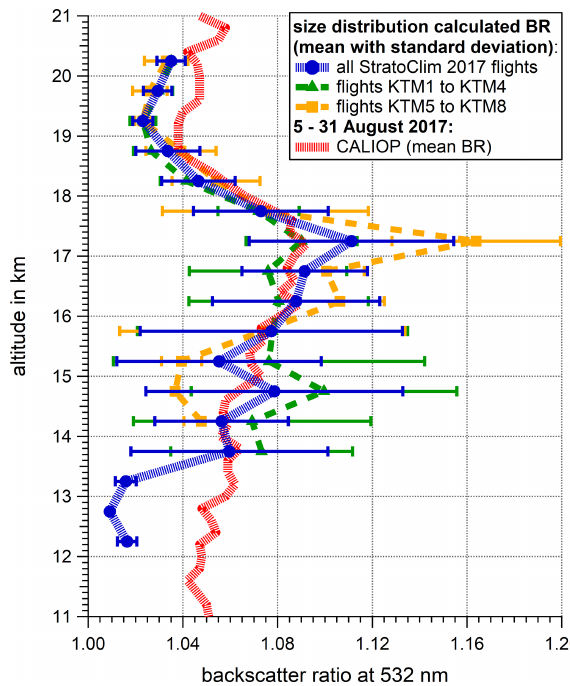
Figure 8. Vertical mean profile of the backscatter ratio at a 532nm wavelength, calculated based on the aerosol size distributions mea- sured during the 2017 StratoClim measurement campaign with the standard deviation shown as horizontal bars. The full period of the 2017 StratoClim field campaign is shown in blue, the first half of the campaign period is shown in green (flights KTM1 to KTM4), and the second half of the campaign period is shown in orange (flights KTM5 to KTM8). The red line represents the vertical mean BR pro- file measured by CALIOP between 5 and 31 August